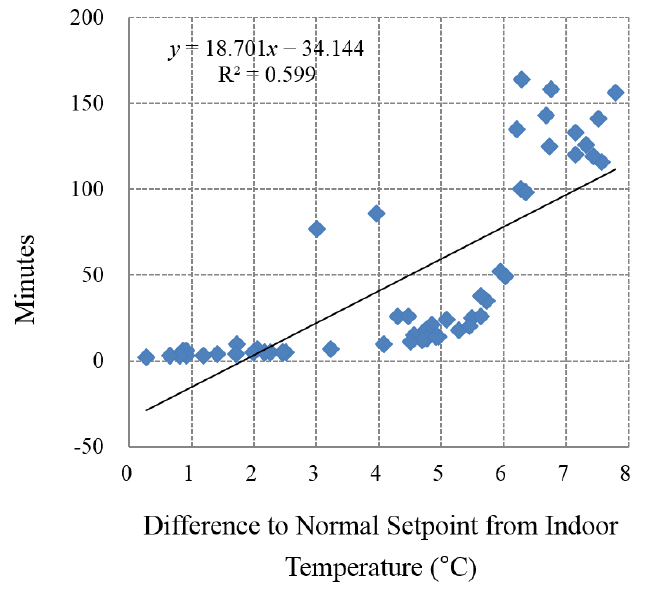
Figure 10. Relationship between the indoor temperature from the normal set-point temperature ( TEMP DIF ) and the required minutes for restoring from the current temperature to the normal set-point temperature.